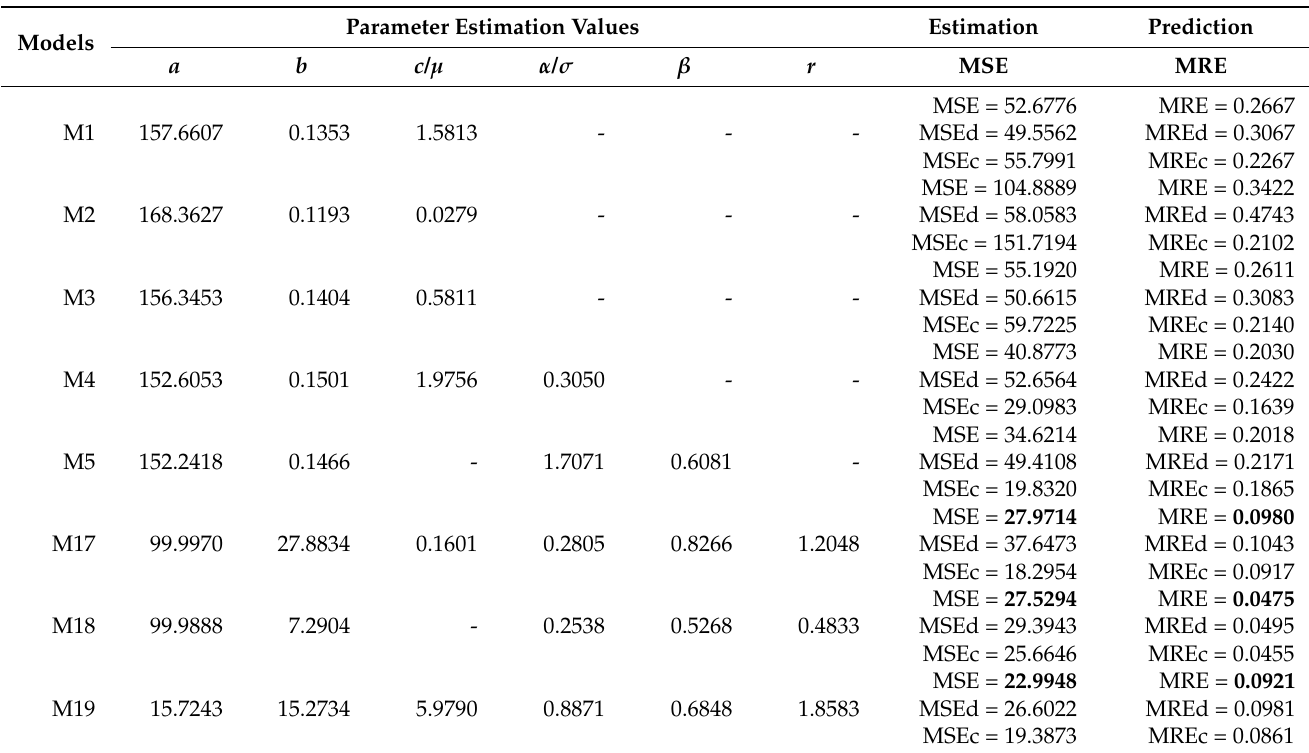
Table 3. Estimates of parameters and performance values of paired models for DS-1. Parameter Estimation Values Estimation Models